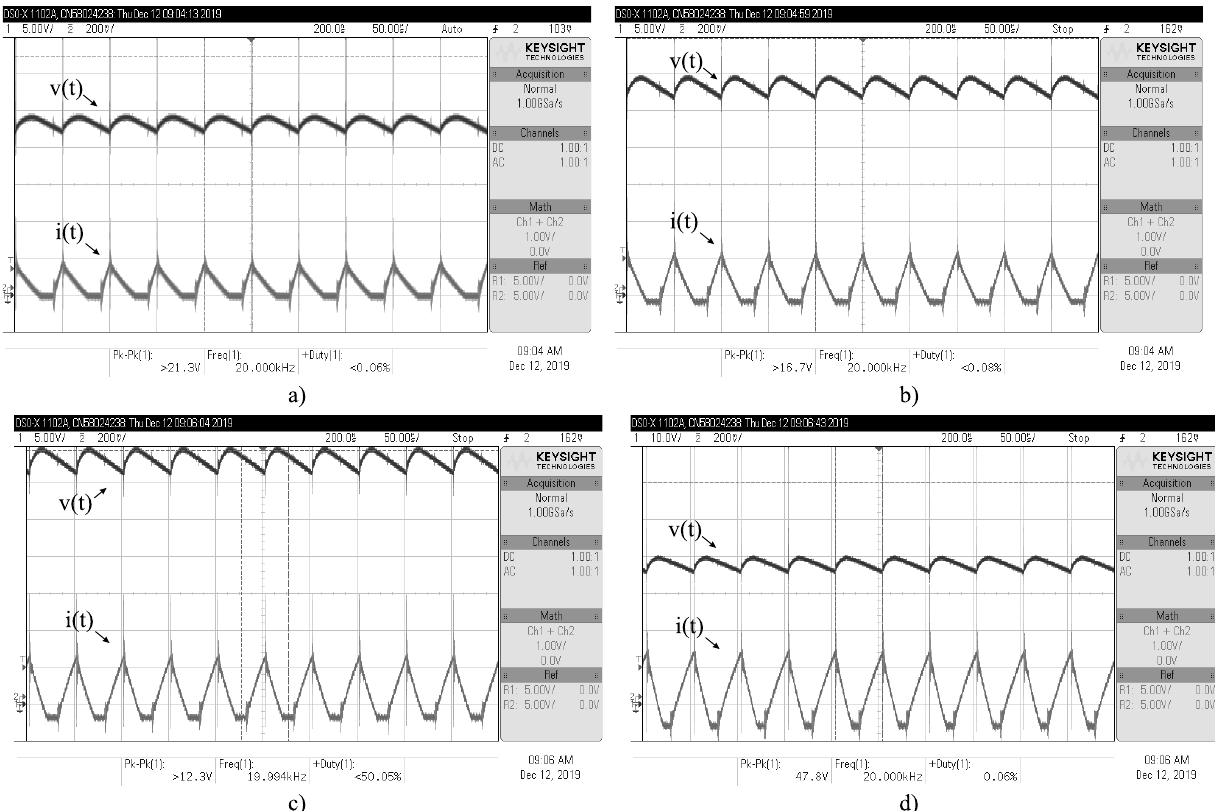
Figure 10. Output voltage and inductor current for the experimental validation, with ( a ) u = 0.1, ( b ) u = 0.2, ( c ) u = 0.3, and ( d ) u = 0.4. The current error is at an average of 0.223 A , and the RMS voltage error is approximately 3.12 V